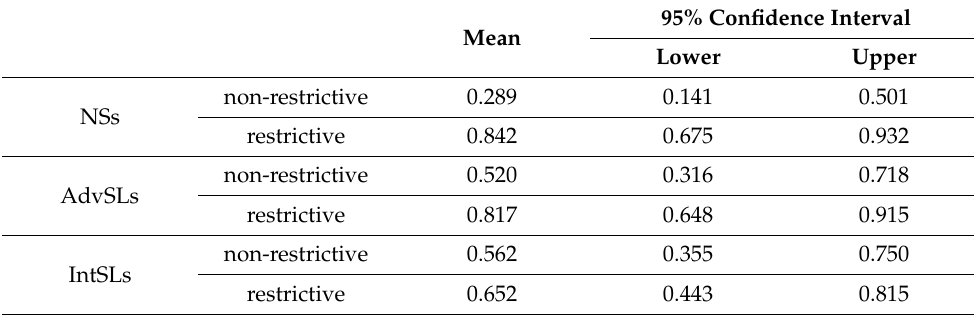
Table 6. Model estimates (probability of prenominal placement).